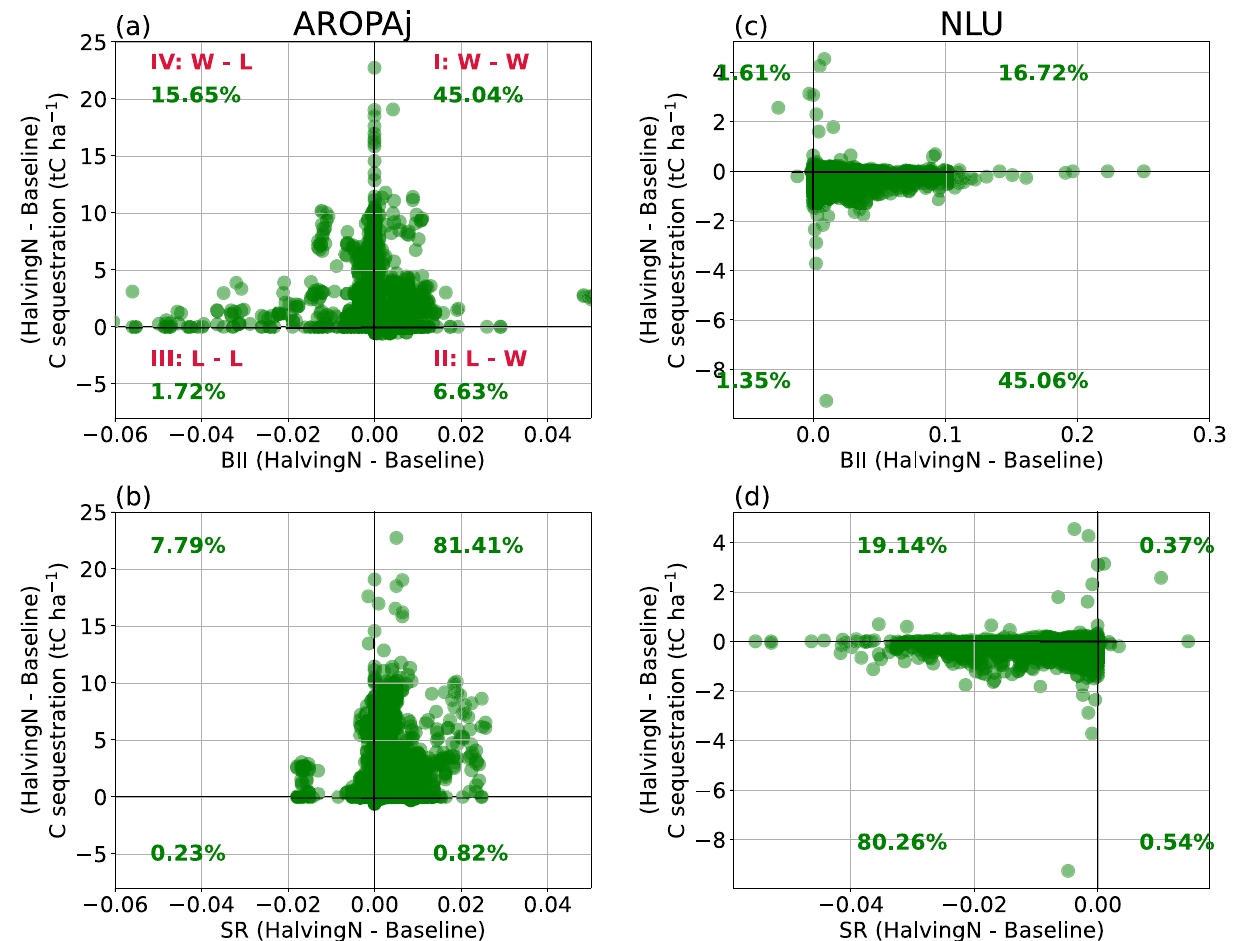
Figure 4. The distribution of spatial grid points across four quadrants described here for AROPAj ( a , b ) and NLU ( c , d ) scenarios. Panels ( a ) and ( c ) describe the benefits in terms of carbon (C) sequestration and Biodiversity Intactness indicator (BII). Panels ( b ) and ( d ) describe the benefits in terms of C sequestration and Species Richness (SR). Y-axis is the change in C sequestration between Halving-N and Baseline at each grid point across the EU as simulated by ORCHIDEE-crop. X-axis is the change in BII ( a , c ) and SR ( b , d ) between Halving-N and Baseline at each grid point across the EU as computed by the PREDICTS model. The text in the panel ( a ): I quadrant “W–W” refers to Win–Win situation (+ ve change in C sequestration and BII), II quadrant “L–W” refers to “Loss–Win” situation (− ve change in C sequestration while + ve change in BII), III quadrant “L–L” refers to “Loss–Loss” situation (− ve change in both C sequestration and BII), IV quadrant “W–L” refers to “Win–Loss” situation (+ ve change in C sequestration and –ve change in BII). The % change numbers in each quadrant represents the % of total grid points across EU. This figure is created using community data analysis tools with Python version 3.7.10 (CDAT (https:// cdat. llnl.